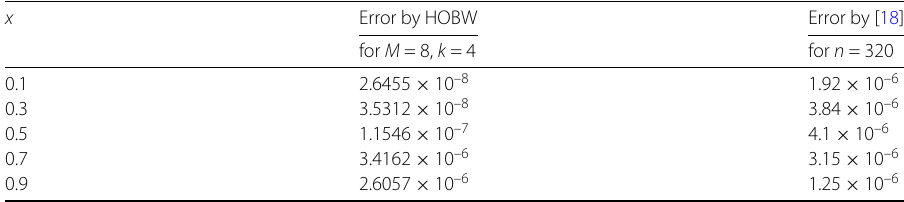
Table 4 Comparison of HOBW results and [18] for Example 7.4